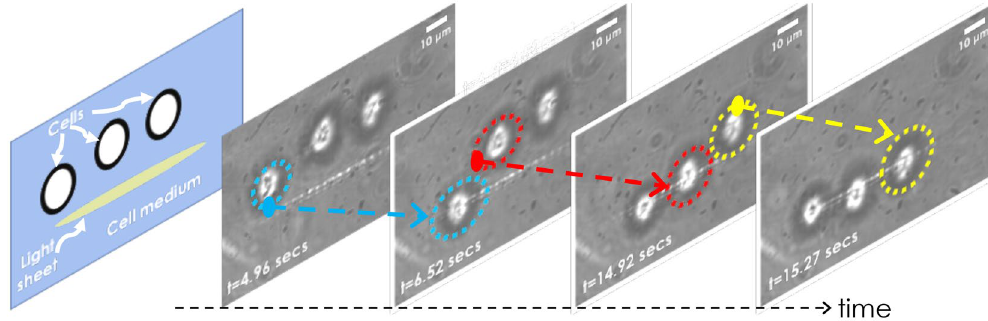
Figure 5. LOT for trapping freely moving HeLa cells suspended in cell medium (DMEM). The randomly moving cells were trapped one-by-one and aligned in a line. See, Supplementary Video 2.